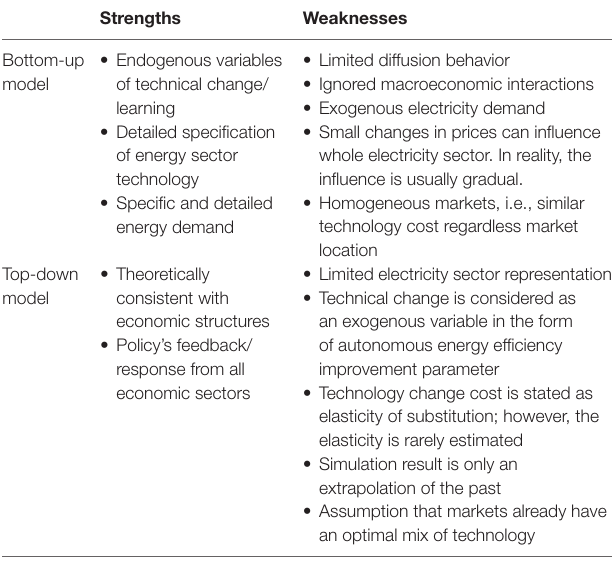
TABLe 1 | Comparison of bottom-up and top-down